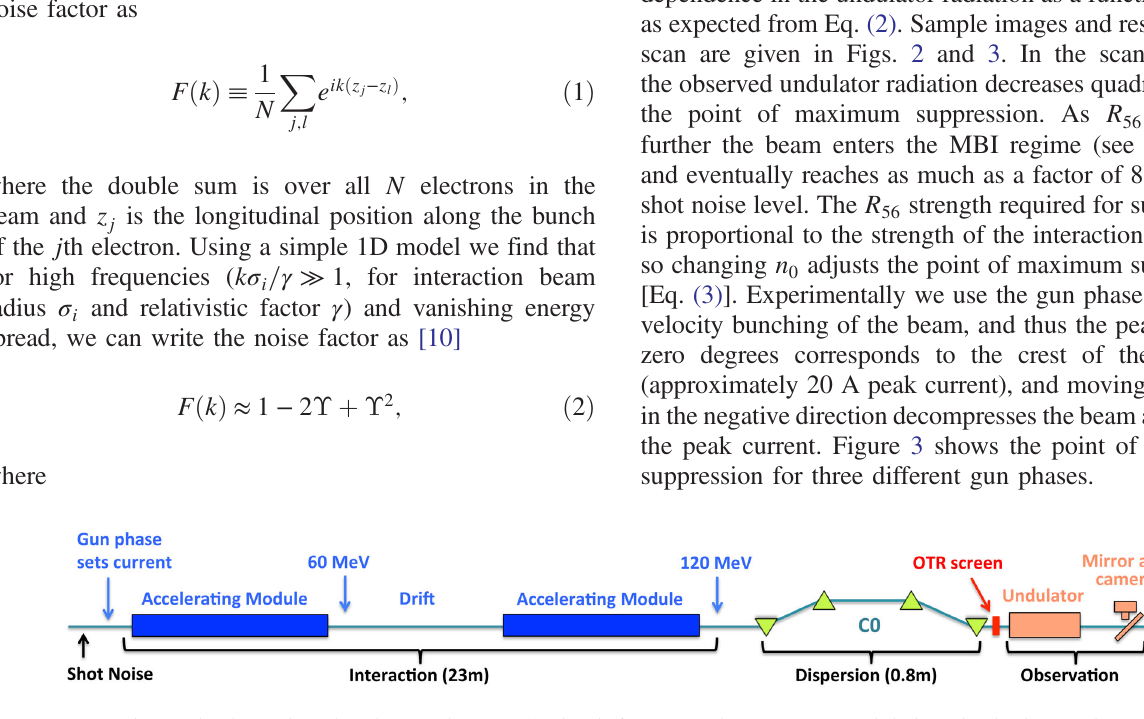
FIG. 1. Experimental schematic: The electron beam ’ s Coulomb forces produce energy modulations in the interaction region. Then passing through the chicane dispersion results in a “ quiet ” electron beam, which emits subradiantly in an undulator. As a control, an OTR screen can be inserted after the chicane to scramble the electrons and reset a shot